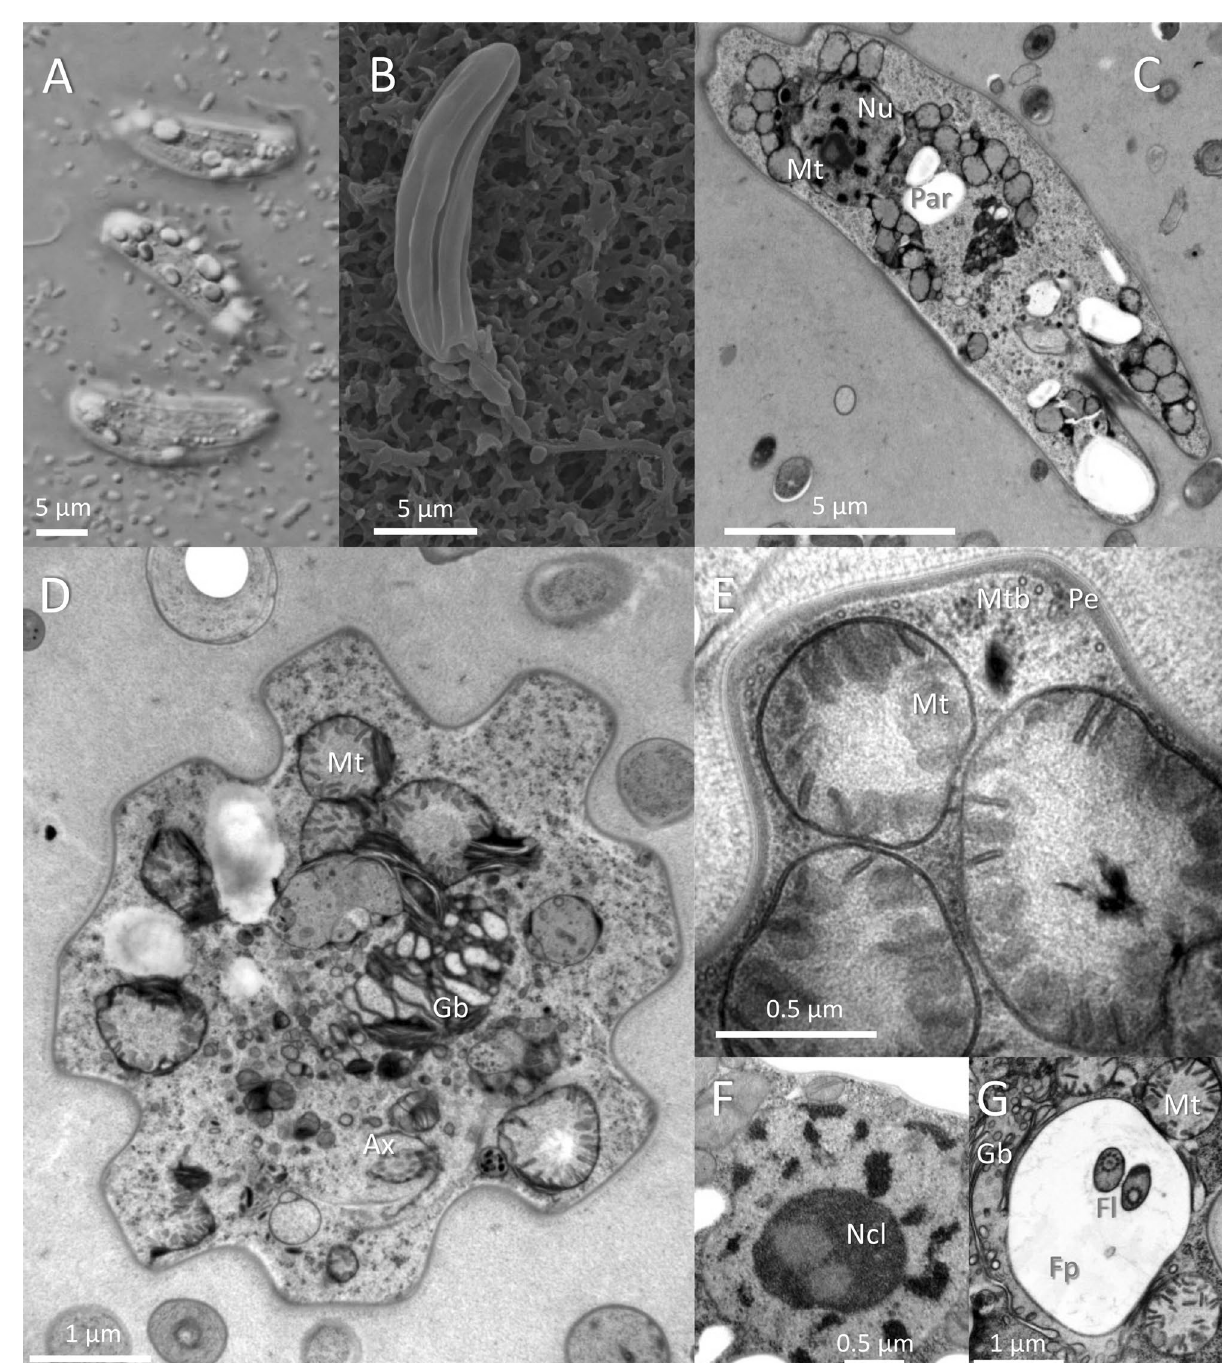
Figure 2. Microscopic investigation of Rhabdomonas costata. Cells in DIC contrast ( A ) with visible pellicular stripes and paramylon grains. SEM microscopy ( B ) of a cell showing surface invaginations and a flagellum inserted in the flagellar pocket. Longitudinal ( C ) and transverse ( D ) TEM sections and details of the pellicle and mitochondria ( E ), nucleus ( F ), and flagellar pocket with two flagella ( G ). Ax—axoneme, Gb—Golgi